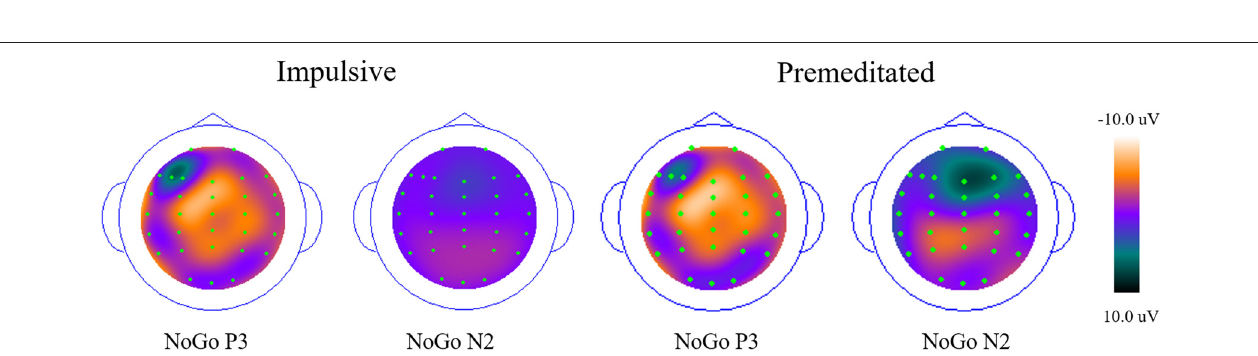
FIGURE 2 | Grand averaged event-related potential (ERP) waveforms for Go and NoGo trials of impulsive and premeditated offenders at the four midline electrodes. Bold lines, Go trials; thin lines, NoGo trials; S, stimulus onset.